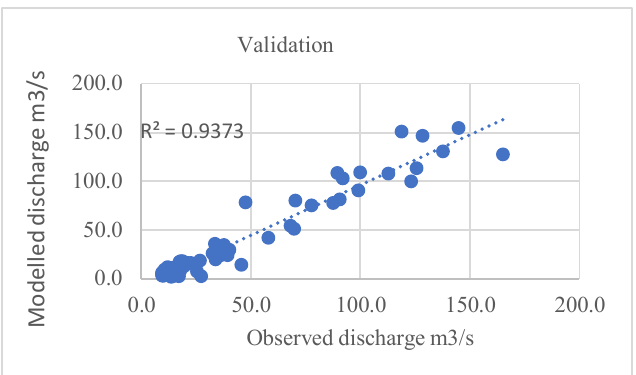
Figure 3. Observed & Simulated monthly flow hydrographs for